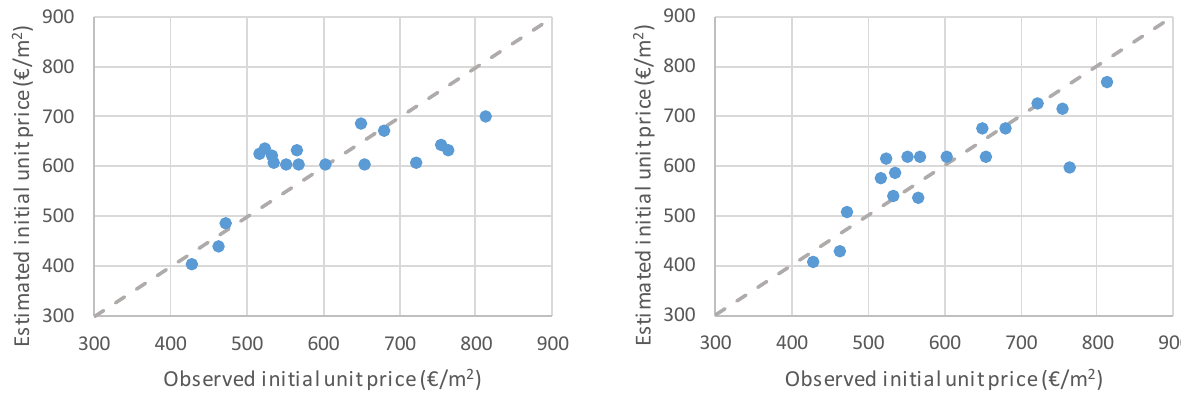
Figure 3. Observed versus estimated initial unit price ( left : Linear model; right : Non-linear model). The apparently lower fit of the models for the unit price is misleading. In fact, multi- plying the area by the initial unit prices estimated with the non-linear model to determine that the total initial price achieves an R2 of 0.97 (Figure 4). This fit difference between the models for the total and unit prices results from the correlation between the total area and the number of floors. This correlation produces multicollinearity between the variables, resulting in the exclusion of the number of floors from any model in which the area is also used. Removing the influence of the area by modeling the unit price allows for the influ- ence of the number of floors to be accounted for, which explains the accuracy increase.